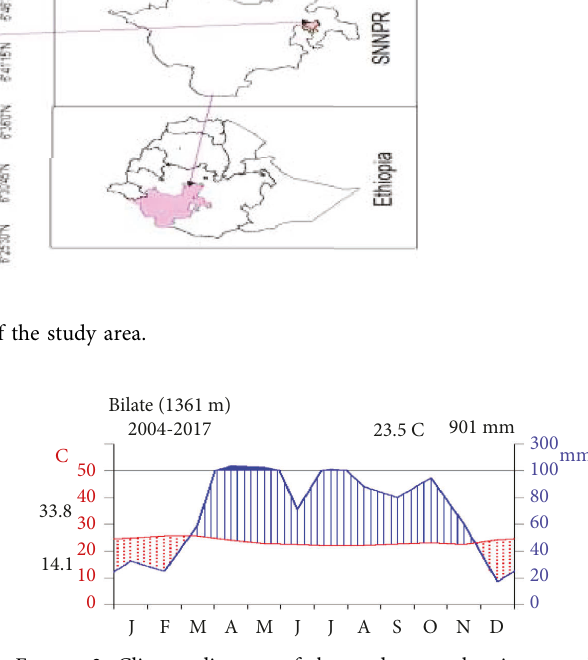
Figure 2: Climate diagram of the study area showing monthly rainfall distribution and temperature variation from 2004 to 2017 at Billate station at an altitude of 1361m.a.i.s.l. Data source: Ethiopian National Meteorological Service Agency, Hawassa